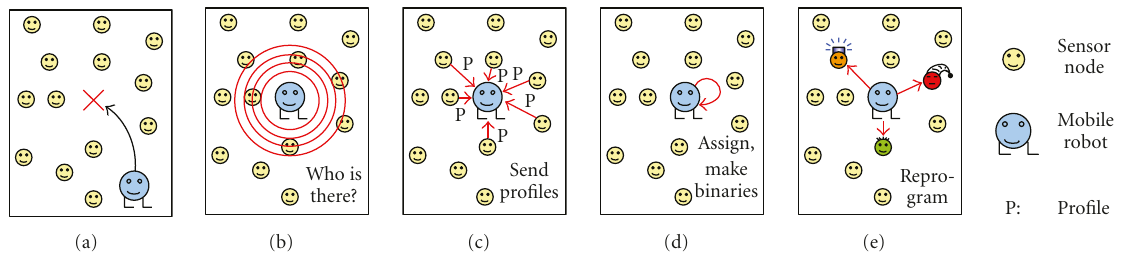
Figure 1: Application scenario for reconfiguration.